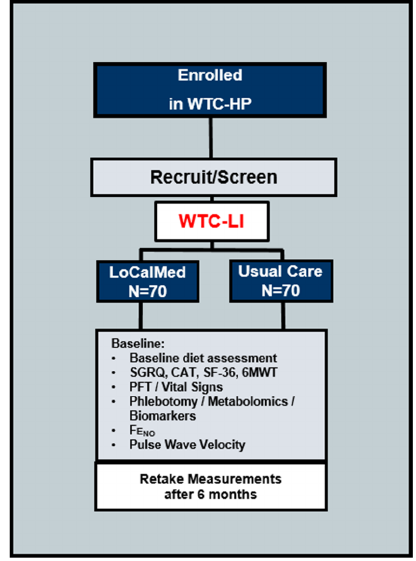
Figure 1. Schematic of the Food Intake REstriction for Health OUtcome Support and Education